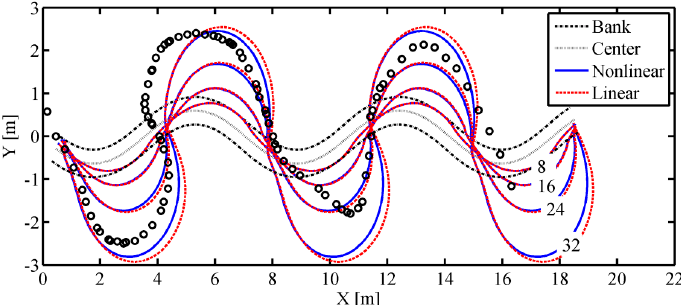
Figure 4. Comparison of the channel centerlines computed from: (1) the nonlinear model (blue solid line); (2) the linear model (red dash line); and (3) the measured data (circles) for the meander evolution simulations of Friedkin’s experiment. Numbers on the lines indicate the evolution time of the channel.